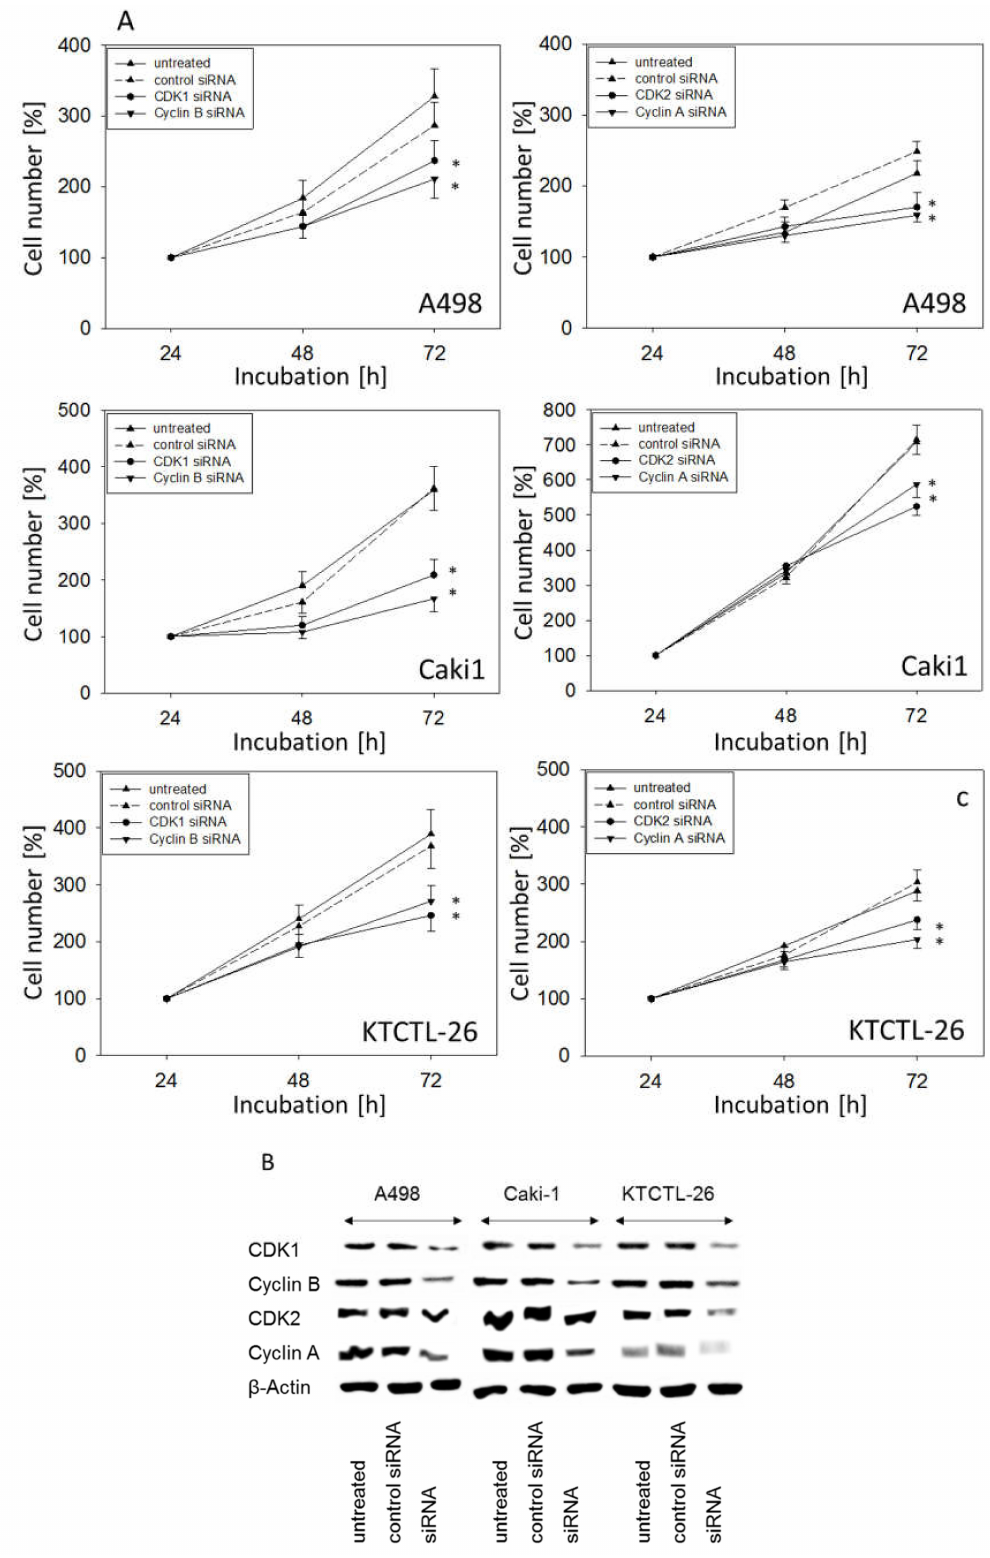
Figure 8. Influence of CDK1, Cyclin B, CDK2, and Cyclin A knock down on tumor cell growth. A498, Caki1, and KTCTL-26 cells were transfected with non-silencing control siRNA, CDK1, Cyclin B, CDK2, or Cyclin A siRNA ( A ). Cell number was set to 100% at 24 h. Knock down was controlled by Western blot ( B ). One representative from six experiments is shown. * indicates significant difference to